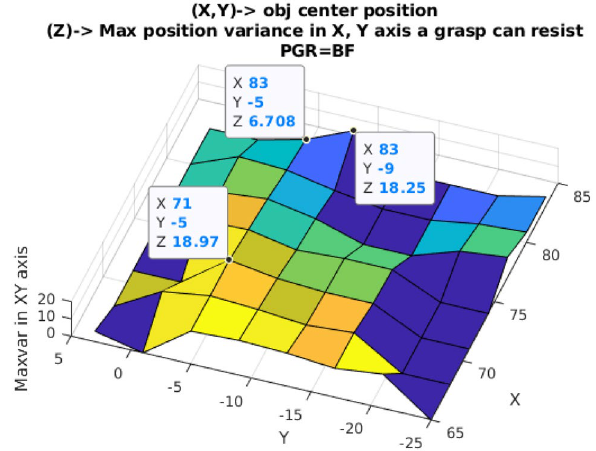
Fig. 16 Maximum position variance for each (X,Y) cube position